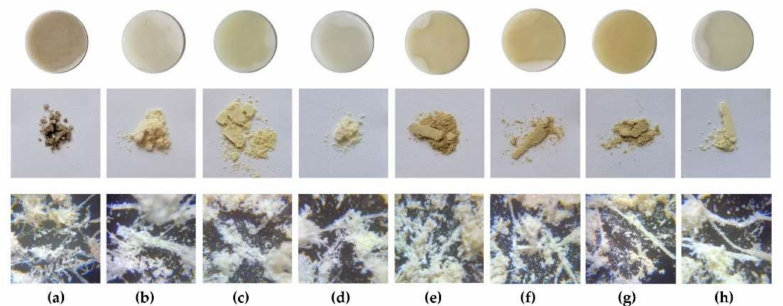
Figure 3. Spectral pellets, macroscopic aspect of ground samples, microscopic observation of coarse ground samples magnified 64 × showing fibrous texture for the samples: ( a ) cellulose (standard), ( b ) Linum usitatissimum ‘Domne¸sti’, ( c ) Cannabis sativa ‘Succesiv’, ( d ) Cannabis sativa ‘Zenit’, ( e ) Corchorus